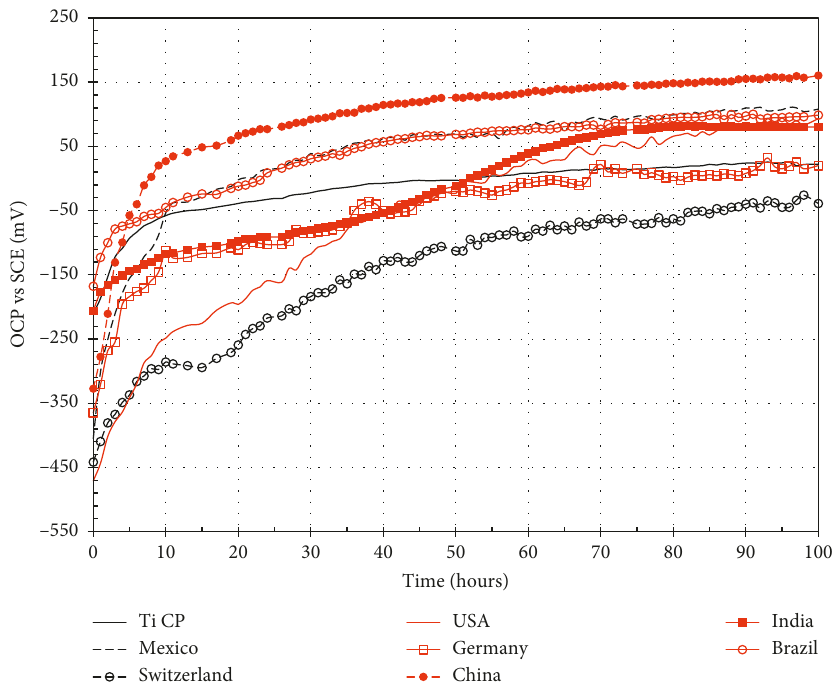
Figure 4: OCP measurements of the biomaterials for 100hours in a 0.9% NaCl solution at 37 ° C.